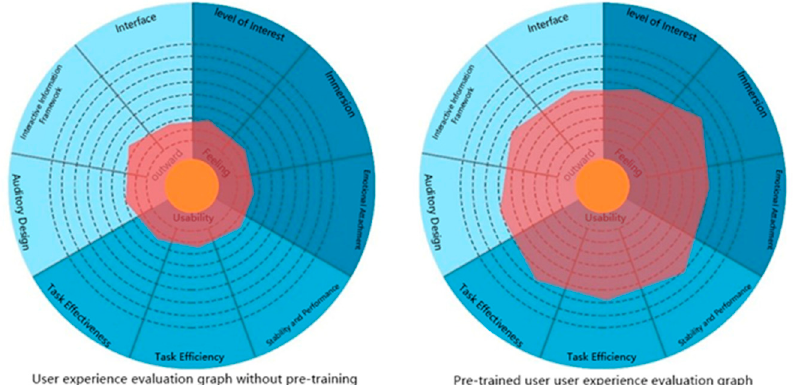
Figure 13. Quantitative user experience evaluation maps of crossing the road for the non-interven- tion group and the intervention group.